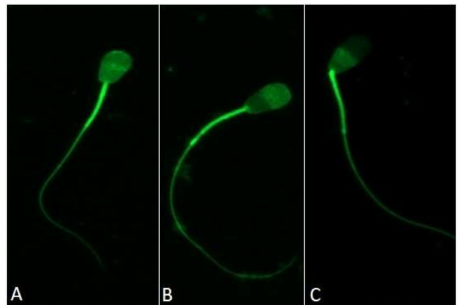
Figure 1. CTCfluorescencepatternsofthespermheadindifferentstagesofthecapacitationprocess. ( A ),non- capacitated—bright fluorescence of the entire sperm head; ( B ), capacitated—prominent fluorescent-positive acrosome and fluorescence-free band in the post-acrosomal region; ( C ), acrosome-reacted sperm—minimal fluorescence signal in the sperm head with a bright signal in the equatorial segment.